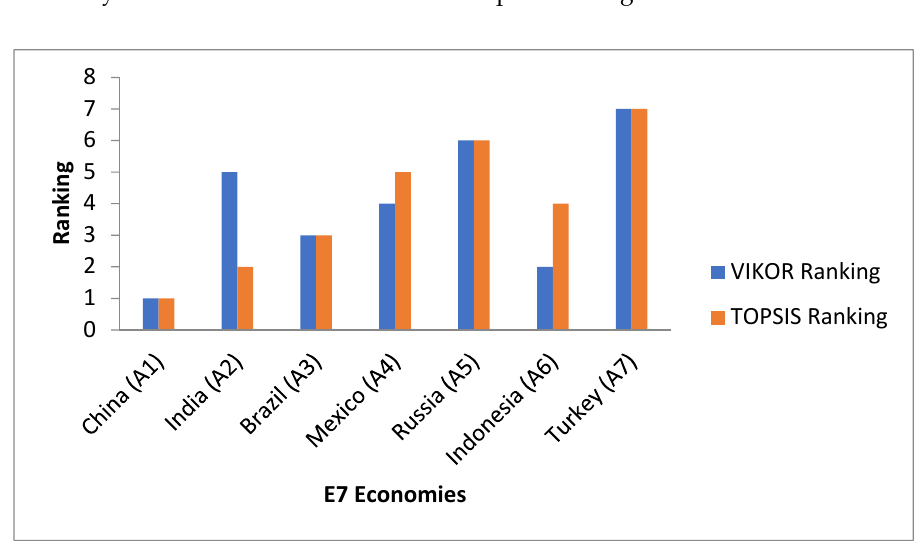
Table 12. Ranking results of the countries using IT2 fuzzy TOPSIS.